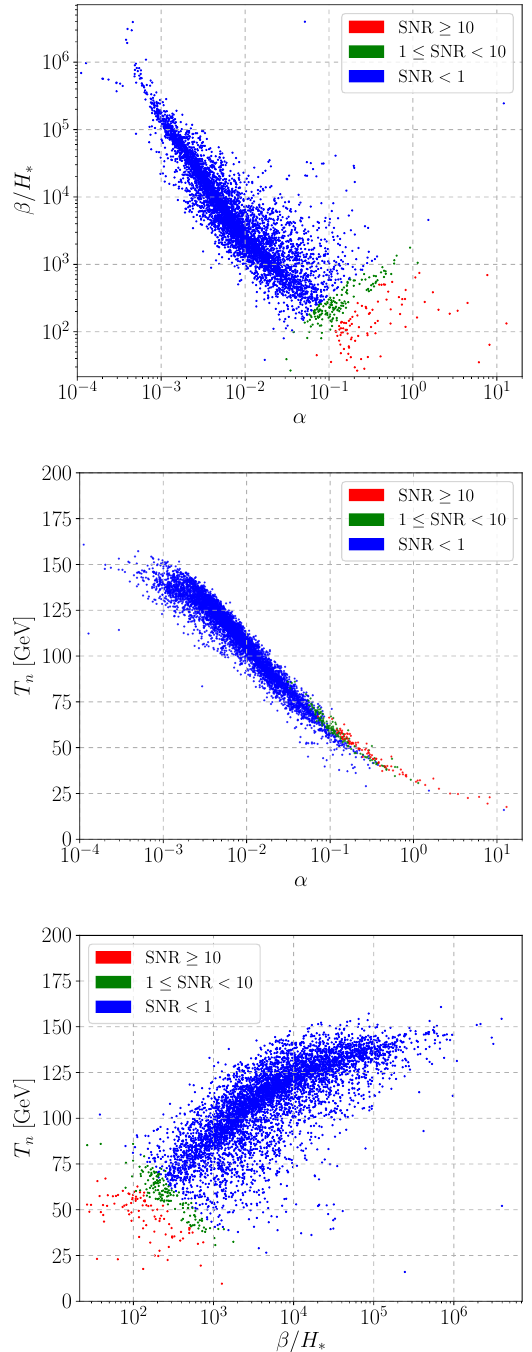
Figure 4. Projections of our full set of xSM parameter points onto the (cid:11) - (cid:12)=H (cid:3) (top), (cid:11) - T n (middle), and (cid:12)=H (cid:3) - T n (bottom) planes. The color code indicates the total SNR (cid:26) for LISA. Note that, in none of the three plots, (cid:26) is a smooth function of the respective parameters on the x - and y -axes. Figure 4 in ref. [26] shows a similar plot of the (cid:11) - (cid:12)=H (cid:3) plane.